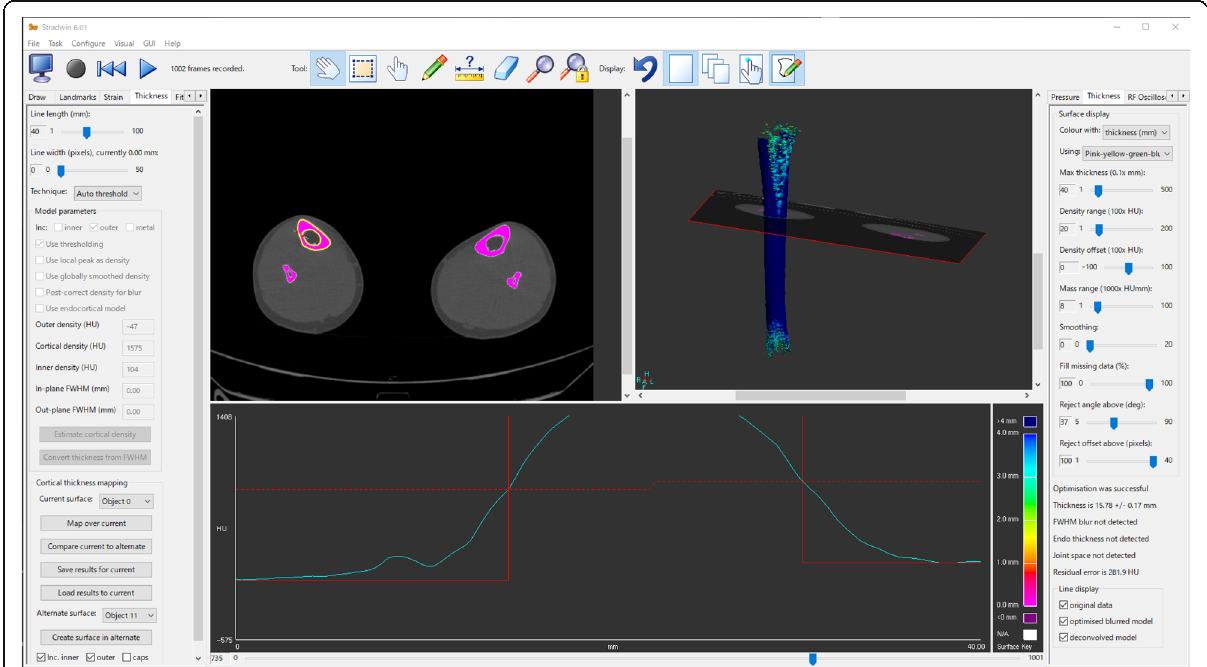
Fig. 1 Automatic calculation using the high-resolution cortical thickness measurement from clinical CT data. The technique relies on a mathematical model of the anatomy and imaging system, which is fitted to the data at a large number of sites around the femur. Given prior segmentation of the tibial diaphysis, CT values are examined along short lines that straddle and are perpendicular to the